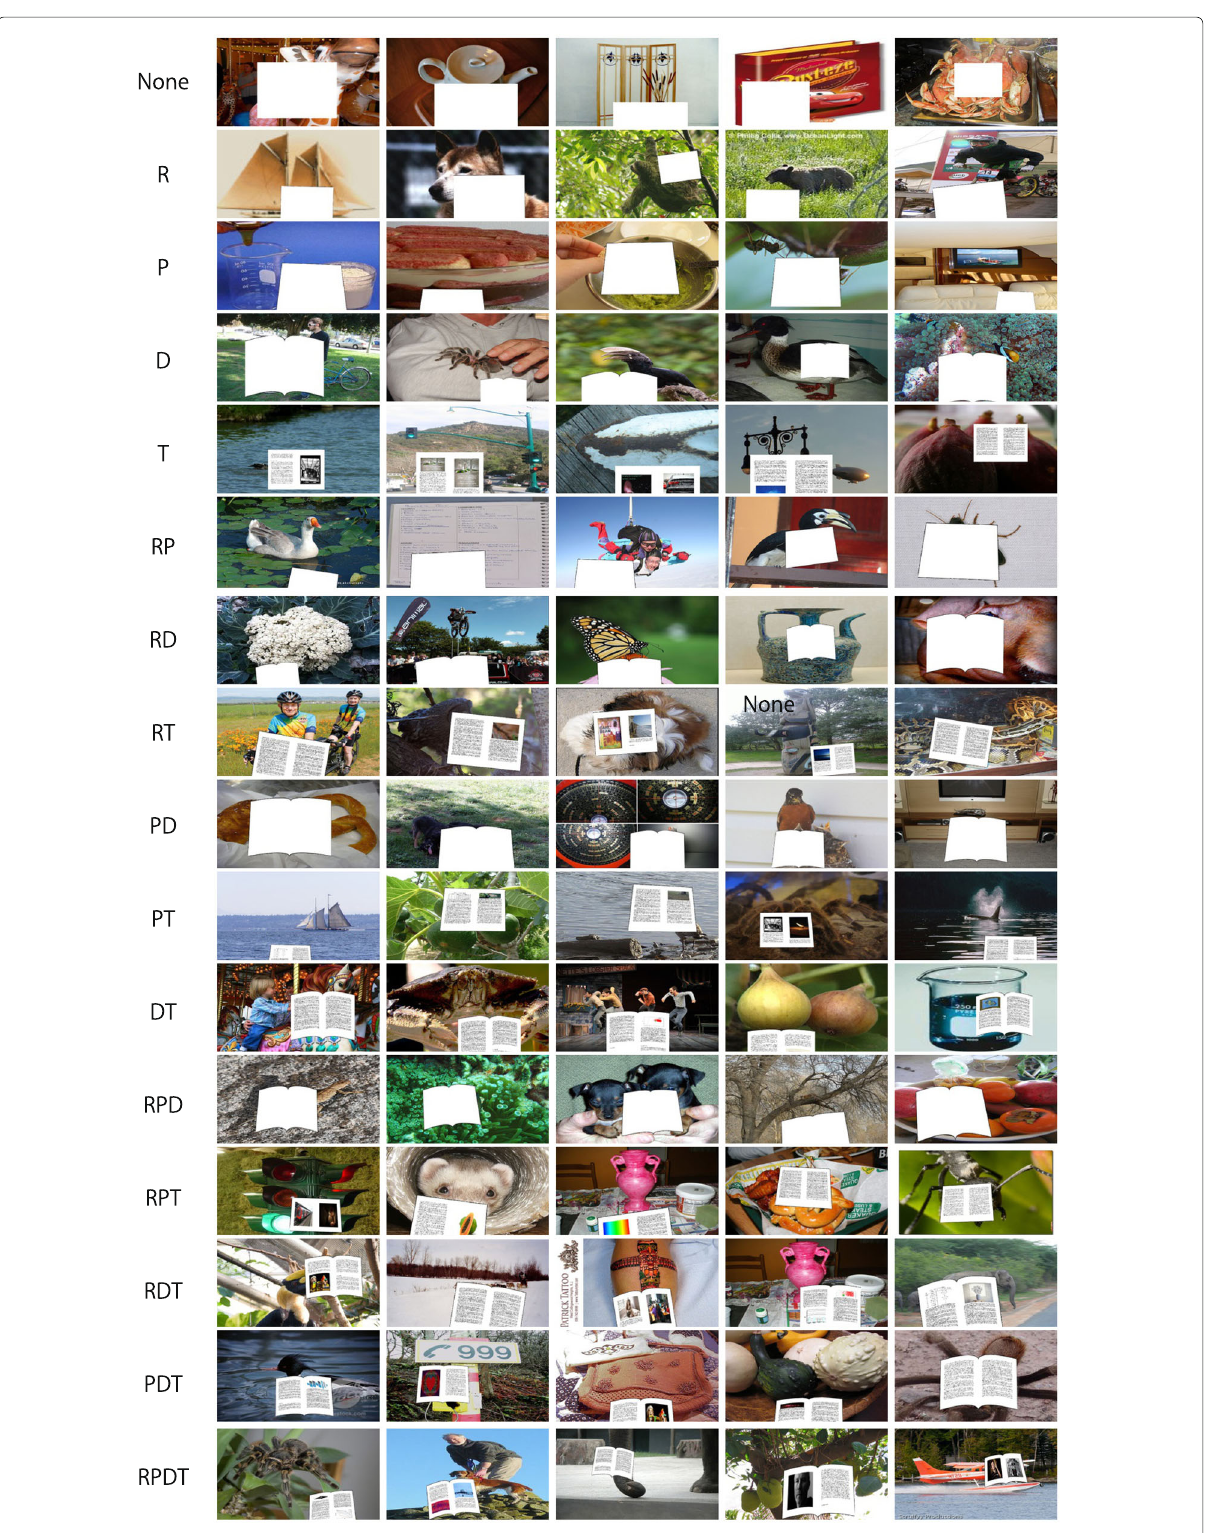
Fig. 8 Example images synthesized by a combination of the four generation processes: R , P , D , and